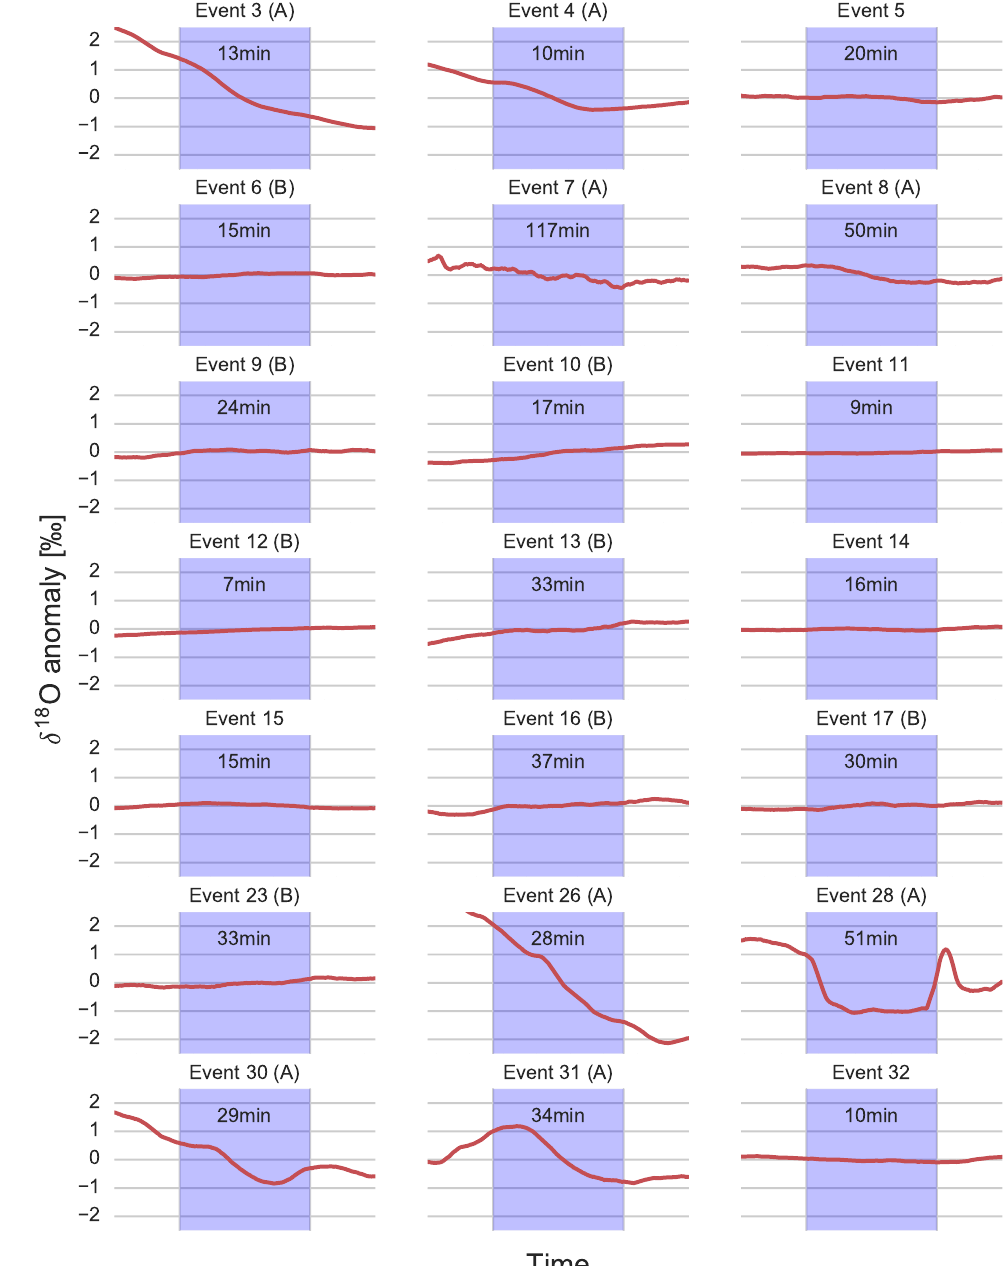
Figure 6. Isotopic evolution during observed rainfall events. The red curve in each panel shows changes in vapor δ 18 O (ordinate) as a function of time (abscissa). The blue shading indicates the duration of the rainfall event, extended to the left and right to show changes in δ 18 O before and after rainfall, respectively. The range of the abscissa depends on the duration of the event as described in the text and noted on the corresponding panel. The ordinate corresponds to the anomaly in δ 18 O relative to the mean value over the plotted time range. The classification of each event (‘A’, ‘B’ or none as discussed in the text) is shown in the title of the corresponding